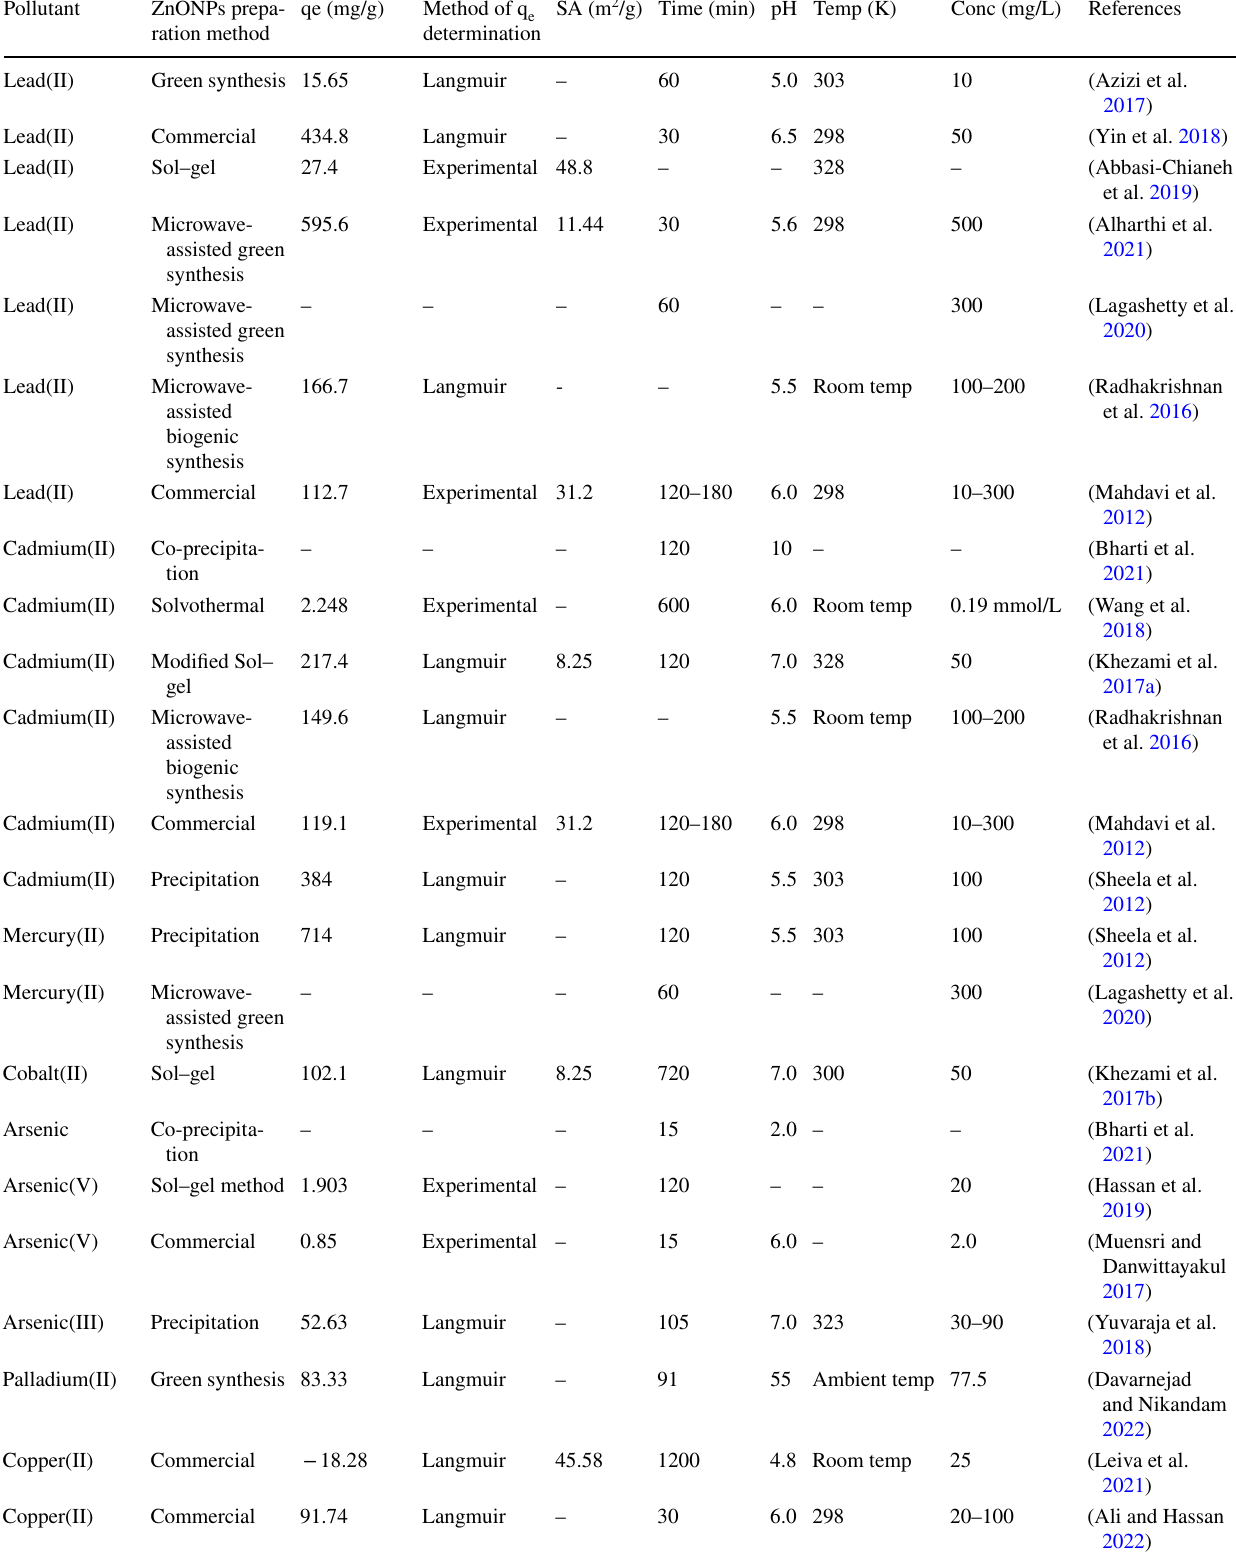
Table 2 Adsorption of heavy metals and radionuclides onto zinc oxide nanoparticles